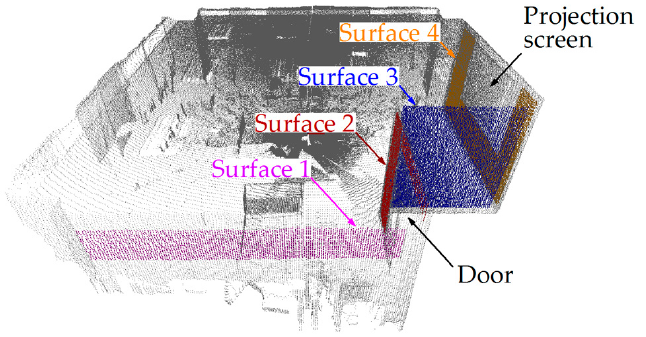
Figure A1. Four surfaces which were used to evaluate the accuracy of the 3D point cloud in shape. We marked them with different colors to distinguish them. The door and the projection screen were both avoided for they might reduce the accuracy of the extraction of the planes.